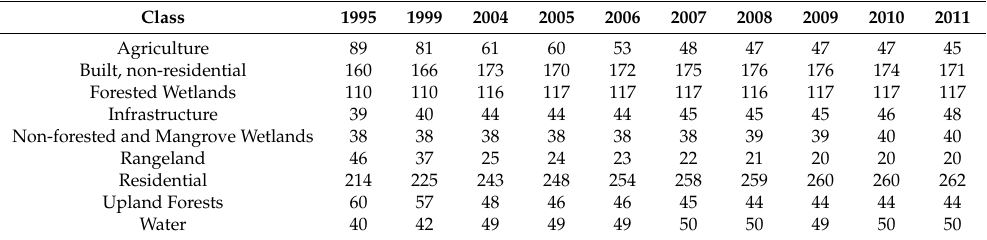
Table 6. Observed spatial areas of LULC classes (km 2 ) in the TBW subbasin by year.